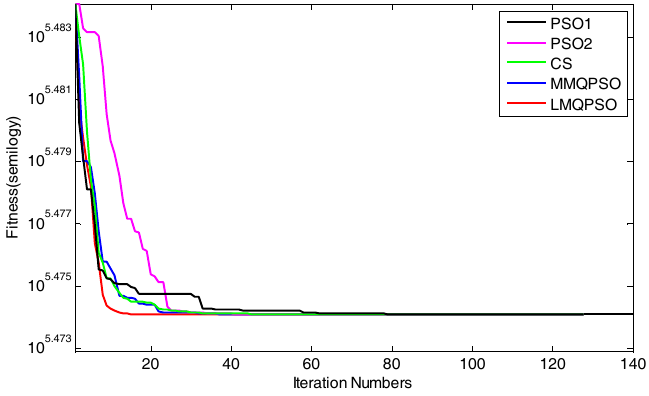
Figure 6. The Convergence of LMQPSO.